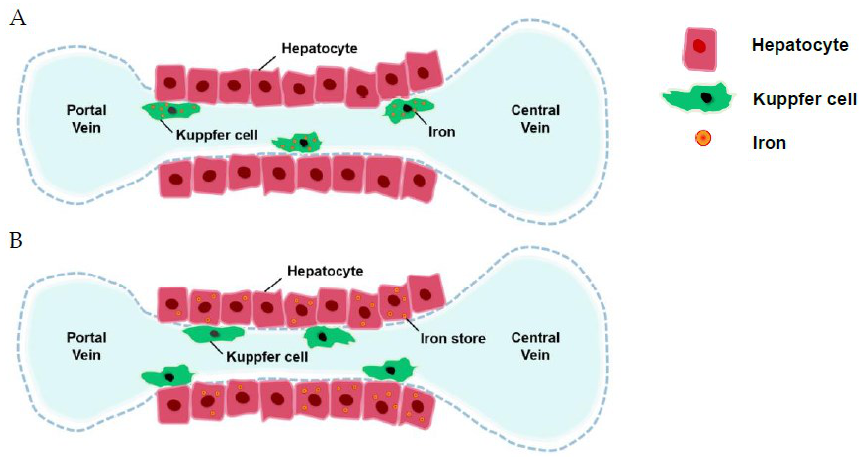
Figure 2. Traditionally, iron is stored in the reticuloendothelial system ( A ), but in thalassemia intermedia, iron is stored in hepatocytes ( B ).